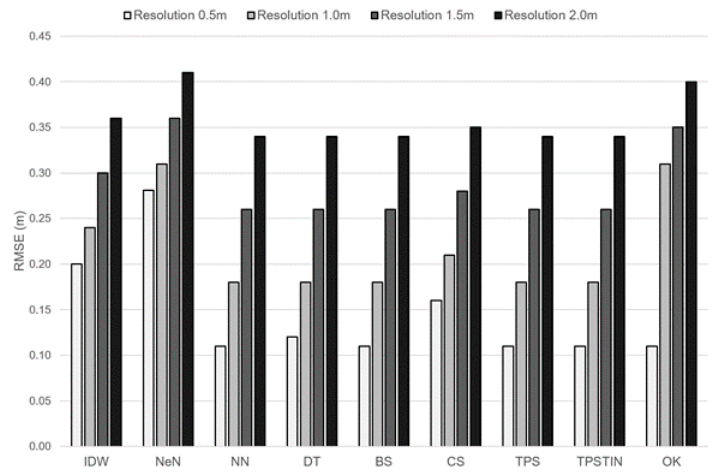
Figure 3. Interpolation accuracy at di ff erent model resolutions.